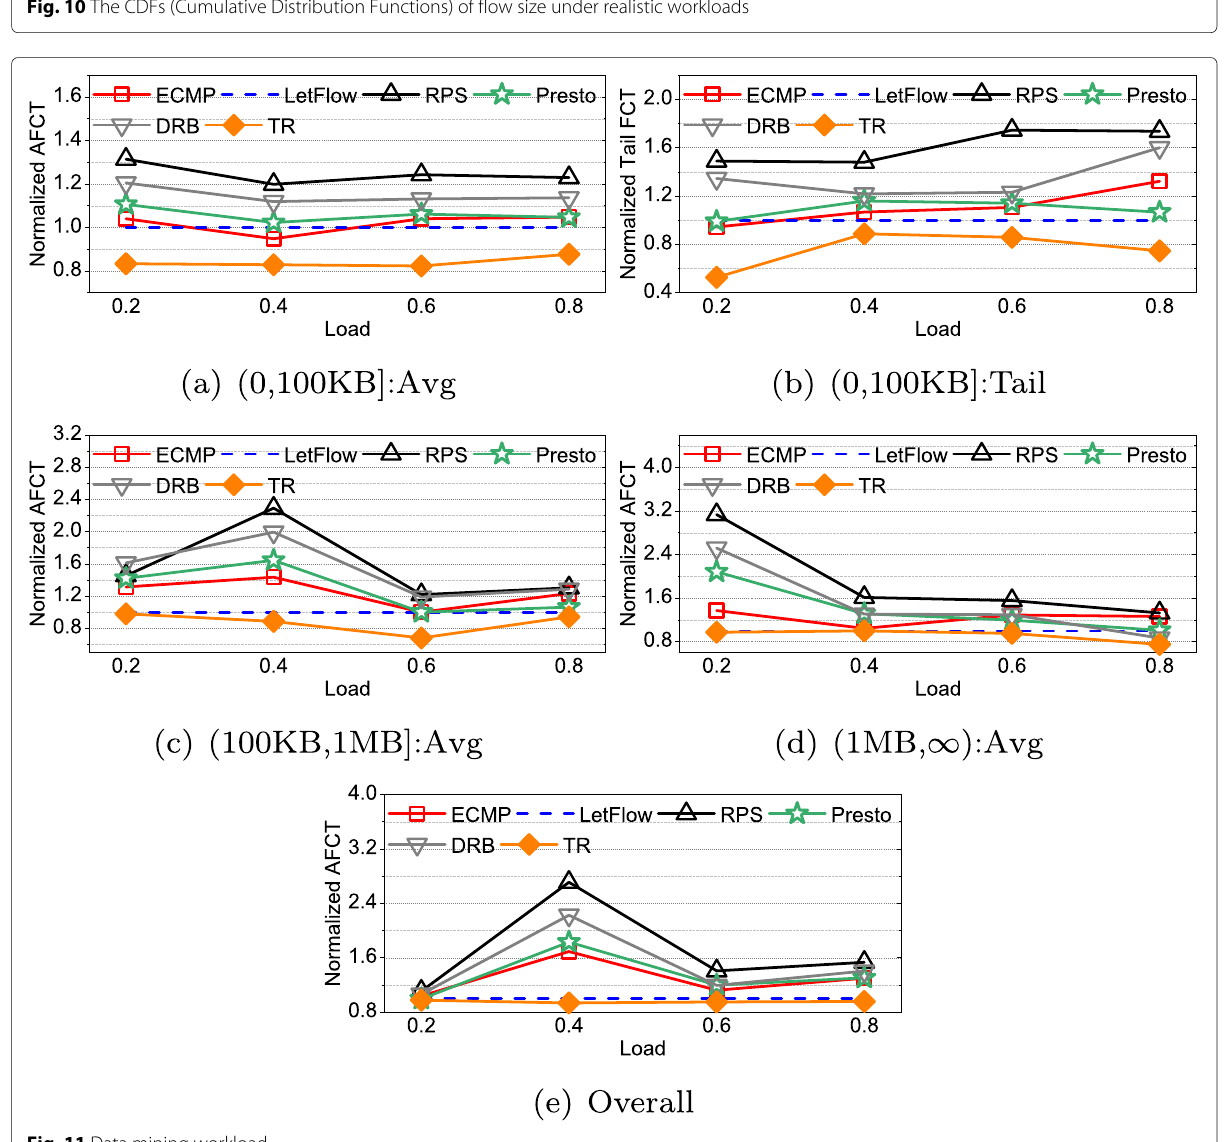
Fig. 11 Data mining